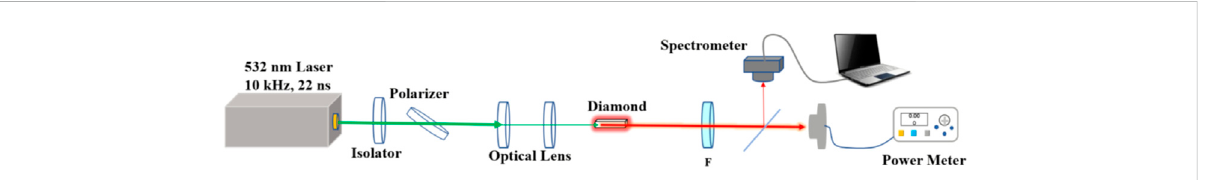
FIGURE 11 Schematic of the diamond Raman red laser in Ref. [18]. Image originally published in Ref. [18] and reproduced with permission from ELSEVIER BV.